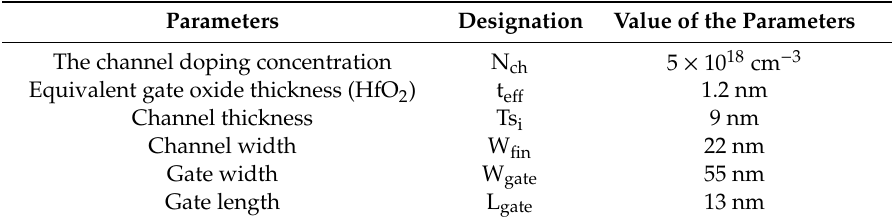
Figure 5. The structure of the simulated JL MOSFET ( a ) and comparison of I d –V g characteristics of the transistor carried out from simulation and experiment ( b ). Table 2. Parameters of the simulated SOI FinFET.